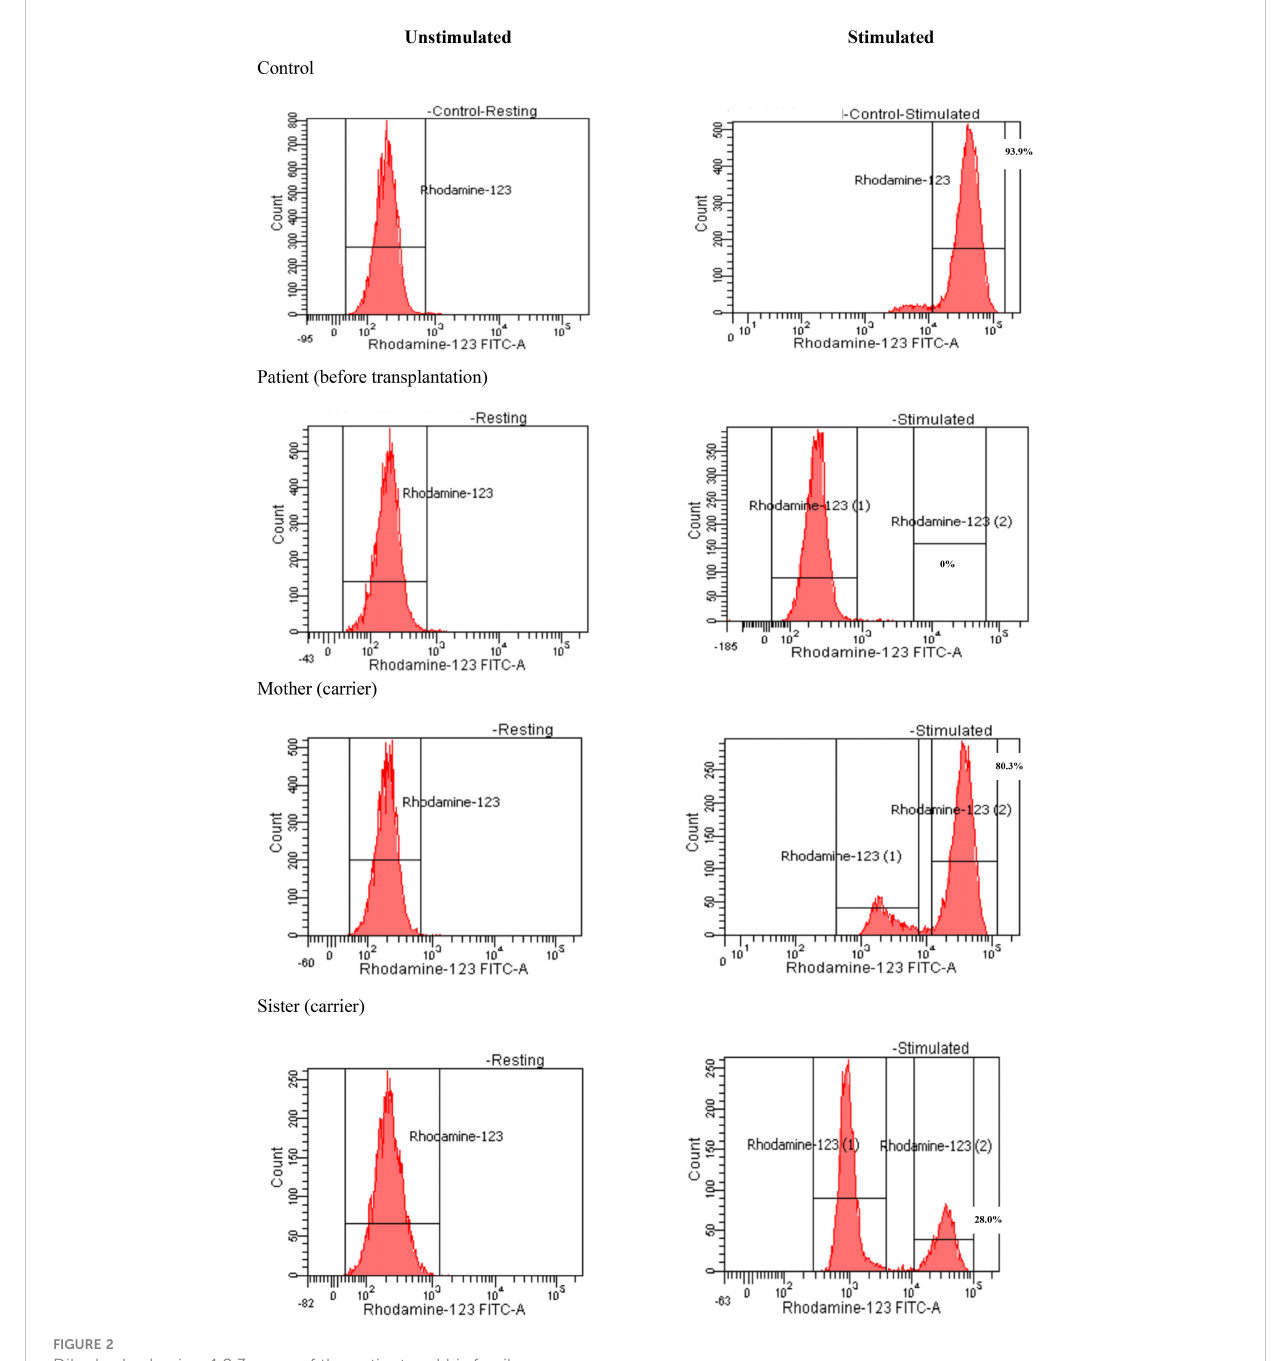
FIGURE 2 Dihydrorhodamine-1,2,3 assay of the patient and his